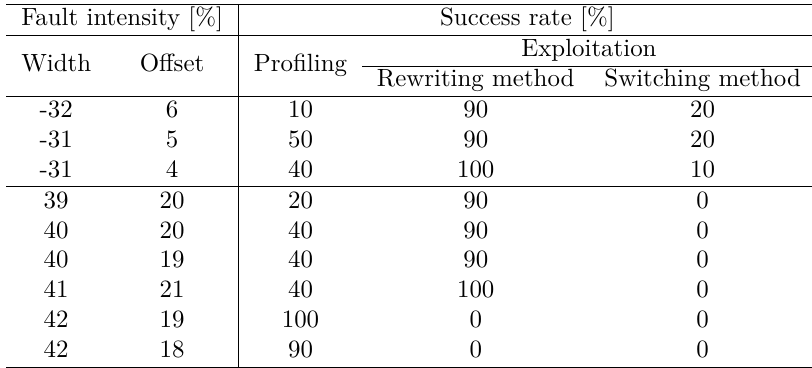
Table 3: Fault intensity parameters and their success rates with 10